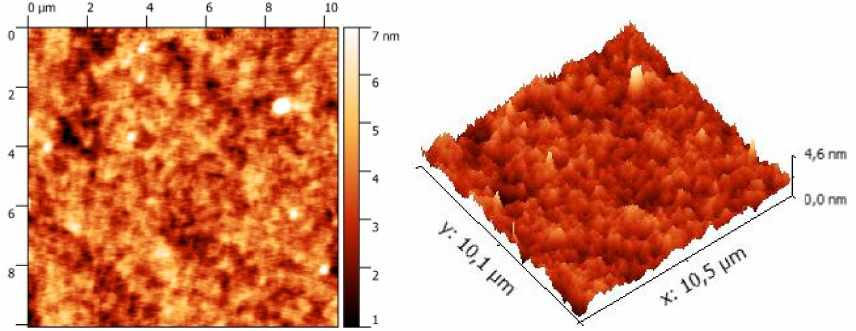
Figure 5. Atomic force microscopy (AFM) images of BDT-C 60 based active layer (10 × 10 µ m 2 ).